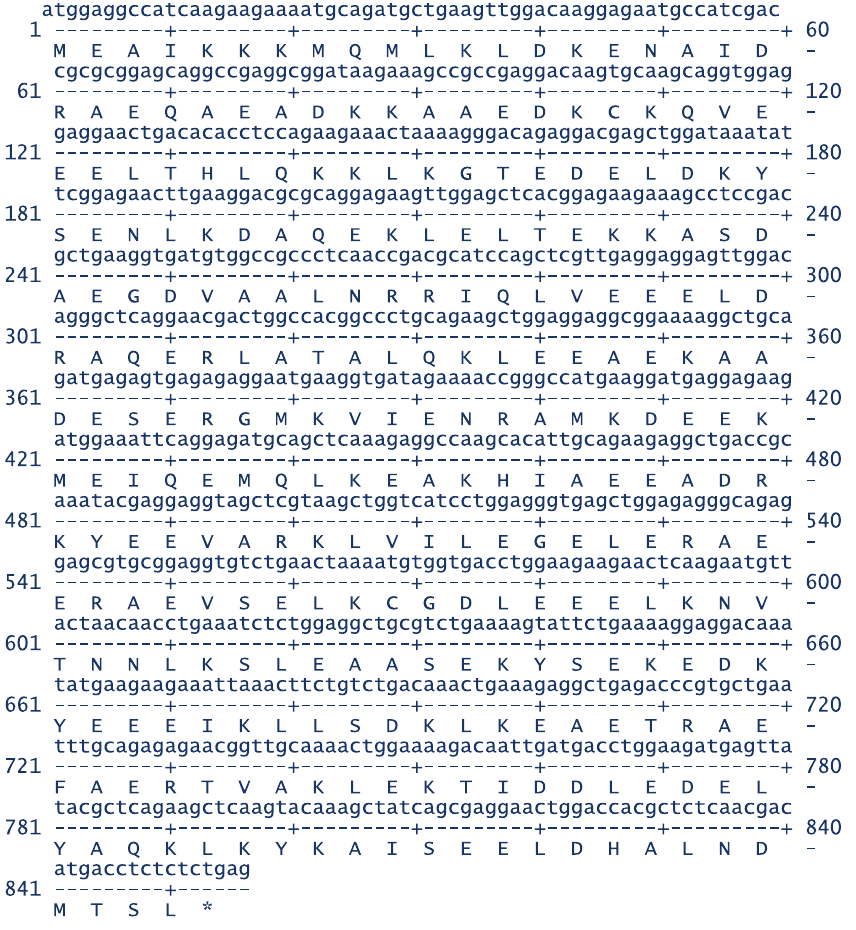
Figure 4: Te nucleotide sequence and derived amino acid sequence of cDNA for Cyn heart TPM4 α